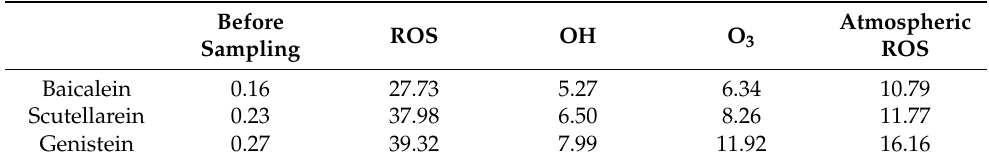
Table 4. Fluorescence increase (%) of baicalein, scutellarein, and genistein active molecules before and after membrane